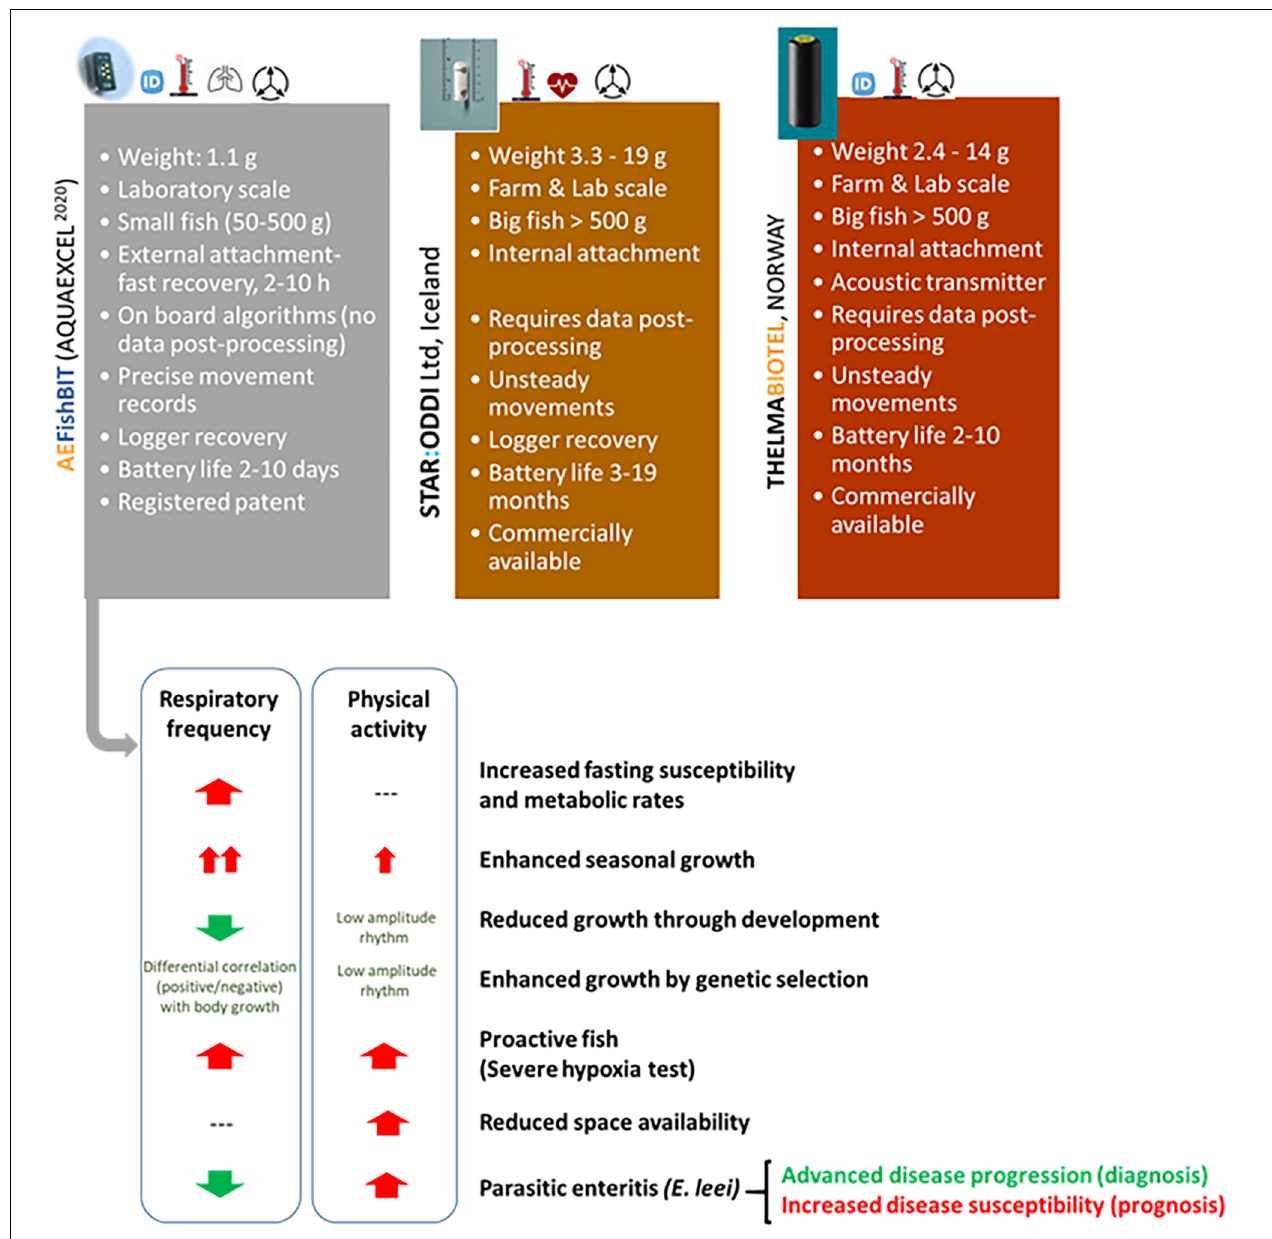
FIGURE 8 | Main features of AEFishBIT and other comparable available devices for fish activity monitoring, with a graphical summary of AEFishBIT outcomes in gilthead sea bream. Partially adapted from data of Perera et al. (2021a) and Rosell-Moll et al.